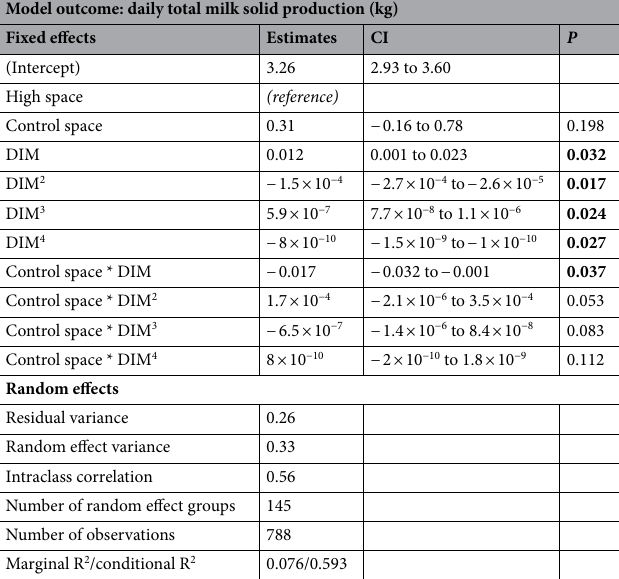
Table 2. Results from the mixed effects model to predict daily milk constituent production (kg) from monthly milk recording samples using trial group and days in milk (DIM) using monthly milk recording data from a year-long randomised controlled trial to evaluate the impact of living space on dairy cow productivity. Significant values are in